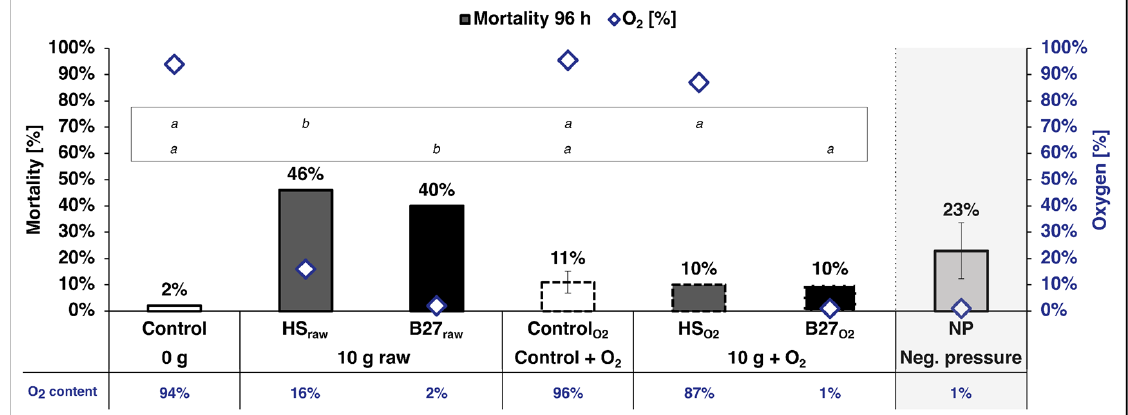
Figure 3. Mortality of the larvae exposed to sediment from the Halensee (HS) and B27 settling ponds in non-aerated (10 g HS raw /B27 raw ) and individually aerated glasses (10 g HS O2 /B27 O2 ), their measured oxygen content at 96 h, and the mortality in the vacuum flask (low oxygen control; O 2 content calculated; Figure S1). The error bars represent the standard deviation. Fisher’s exact test: df = 4, n = 220, p < 0.0001 *; corrected for multiple comparisons using subsequent Bonferroni–Holm correction. Significant differences indicated by letters; upper row: experiment 3 (HS), bottom row: experiment 4 (B27). Sample size: n = 10; number of larvae: all treatments and control n = 50; NP n = 20. (Control: 10 g sand; 10 g HS raw /B27 raw : 10 g HS/B27 sediment; Control O2 : 10 g sand, continuous aeration; 10 g HS O2 /B27 O2 : 10 g HS/B27 sediment, continuous aeration; all: 100 mL filtered water. NP: larvae in vacuum flask under negative pressure (NP; calculated mean of two experiments; n = 2); 1 cm sand, ~400 mL filtered water).